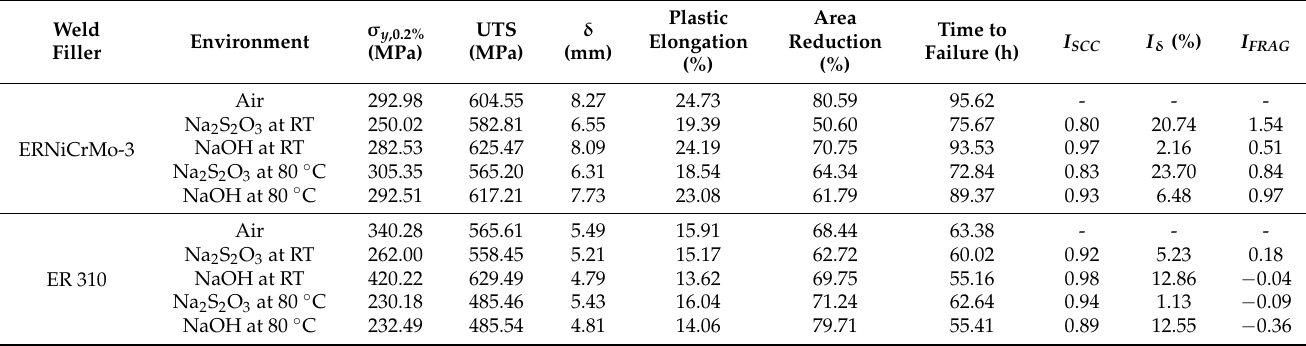
Figure 7. The stress–strain curves of the IN600 welds immersed in 0.1 M Na 2 S 2 O 3 and 5M NaOH at E corr as tested at room temperature and 80 ◦ C for ( a ) ERNiCrMo3 and ( b ) ER310 fillers. Table 2. The mechanical properties of the welded joints obtained from the different SSR test conditions and estimated susceptibility indices to SCC. The red color denotes which electrolyte had more effect on the